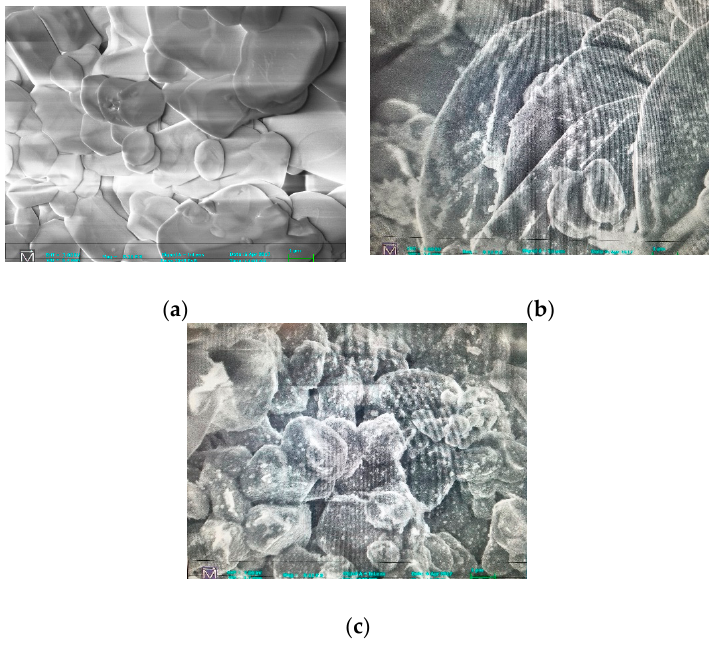
Figure 1. SEM images at magnification of 8.11 K for ( a ) Al 2 O 3 support, ( b ) 30-min and ( c ) 60-min as-deposited electroless CuNiMoP/Al 2 O 3 .